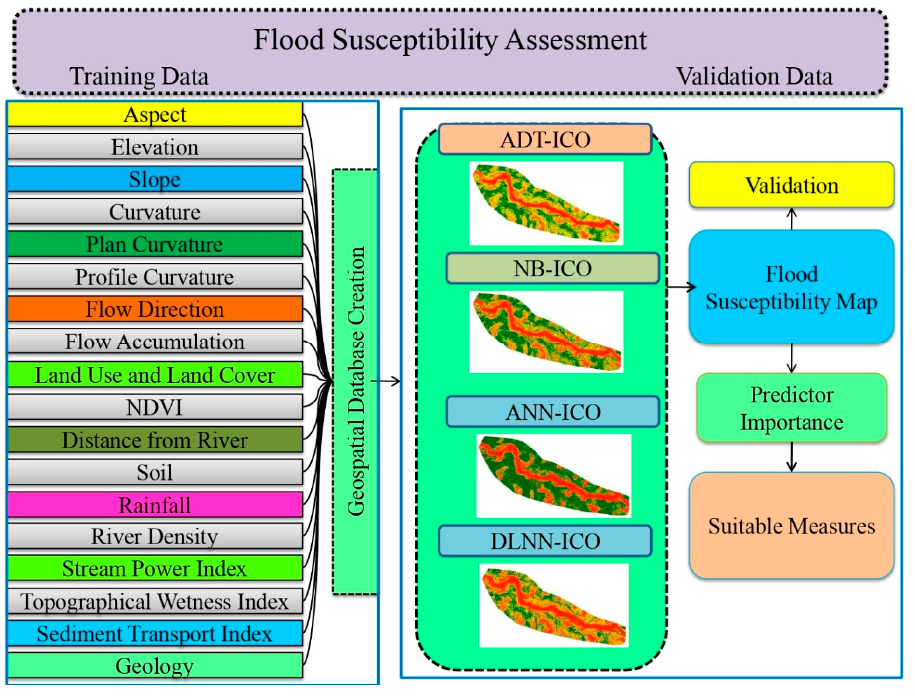
Figure 2. Methodology flow chart.